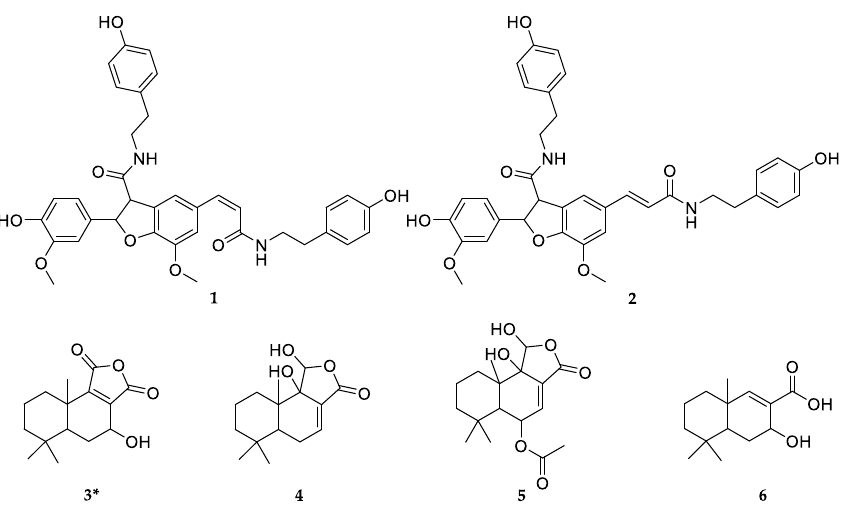
Figure 3. Compounds isolated and identified from WE-P; *: New compound.